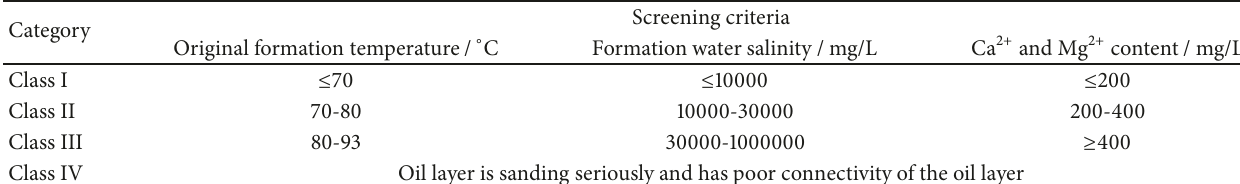
Table 1: Standard of oil layer division in an oil